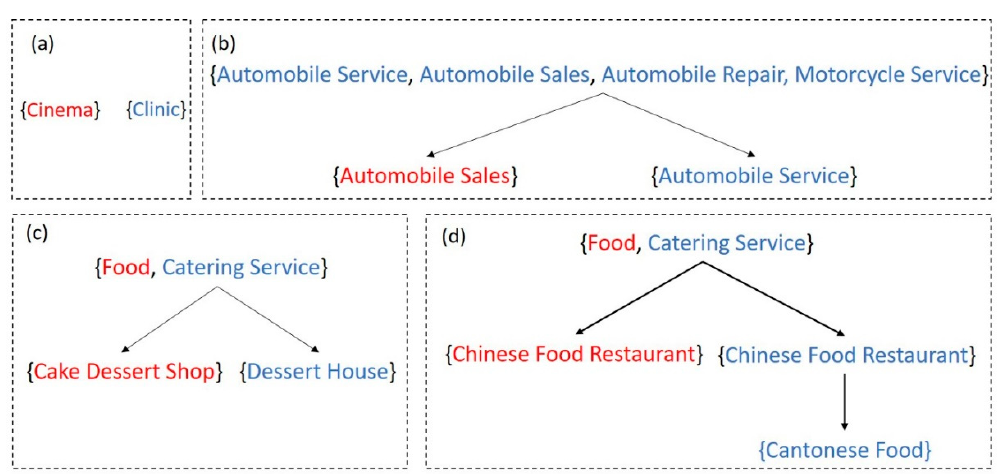
Figure 4. The distance between any two tree nodes. ( a ) The distance is ∞ ; ( b ) The distance is 0 and 1; ( c ) The distance is 2; ( d ) The distance is 3.